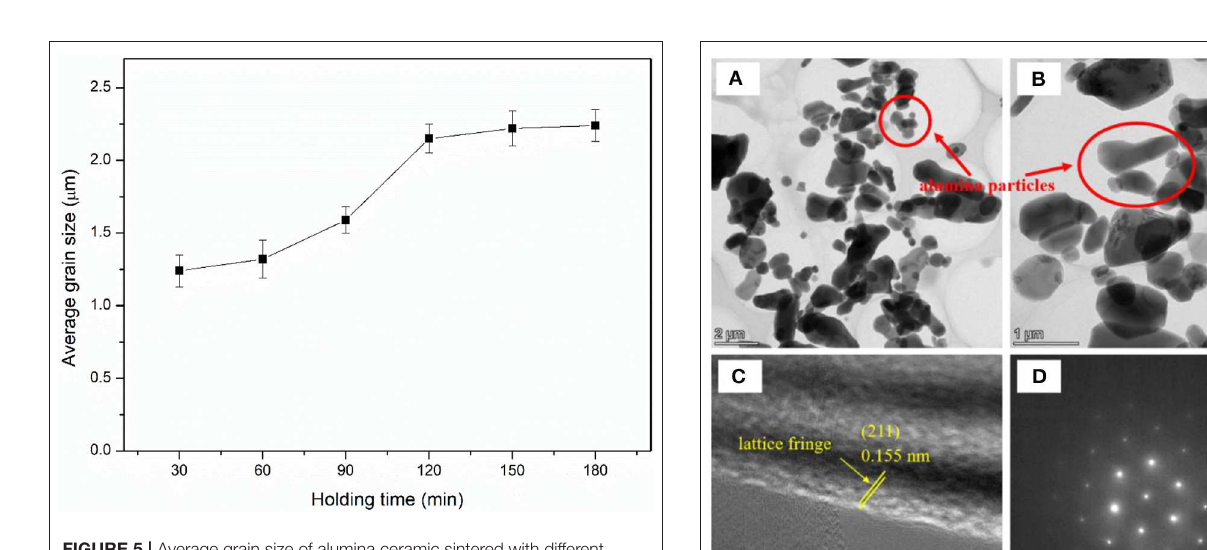
FIGURE 5 | Average grain size of alumina ceramic sintered with different holding times.